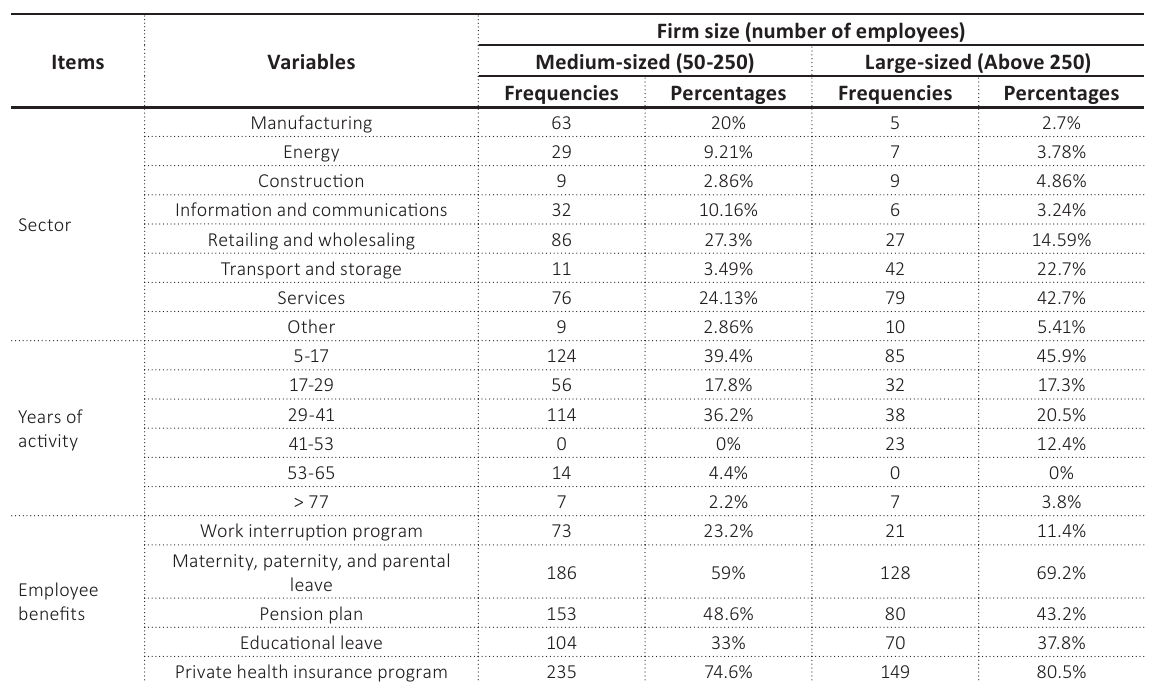
Table 1. Demographic characteristics of firms